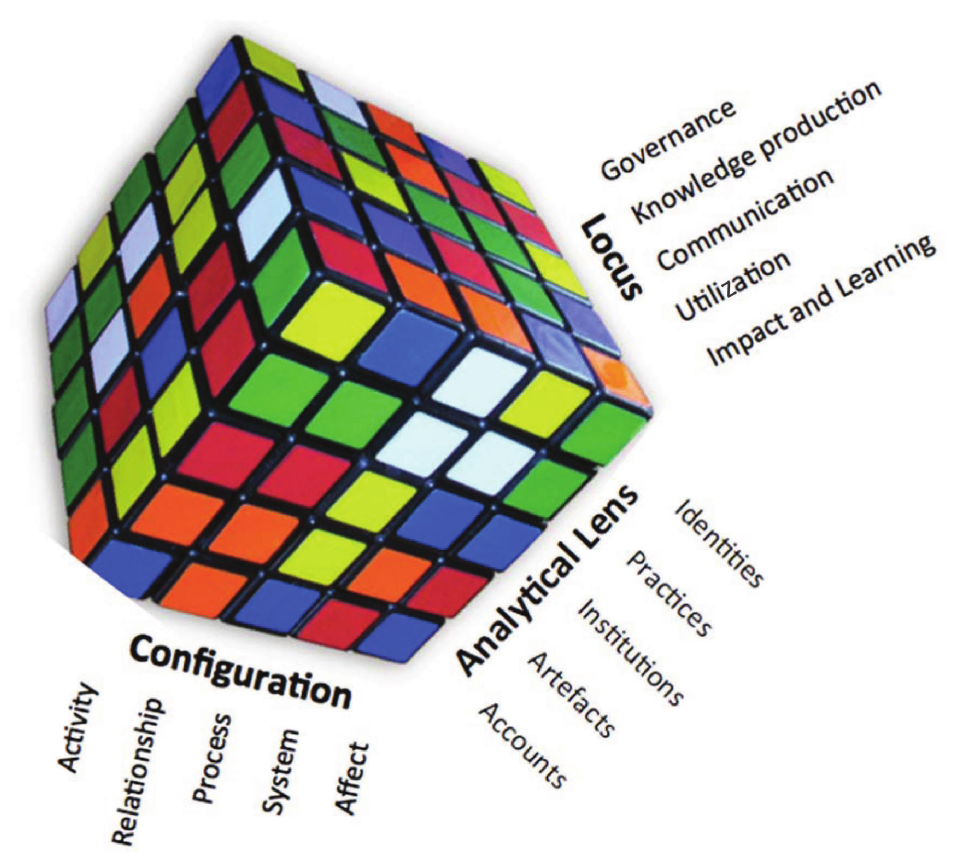
Figure 3: Understanding research engagement: A Rubik’s Cube of the emerging field of research engagement